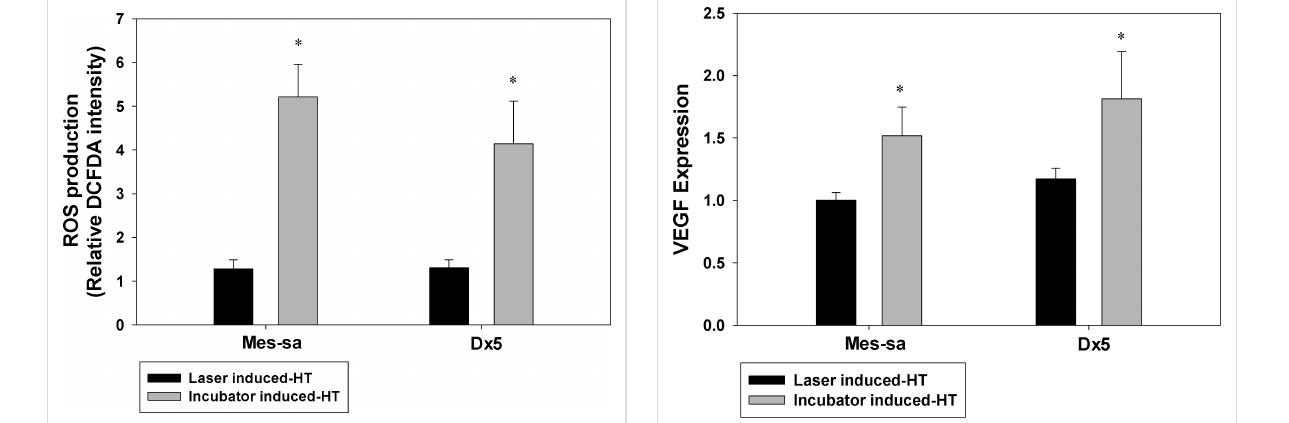
Figure 3: HT-induced ROS production following laser/NPs and incu- bator was measured in MES-SA and Dx5 cells. Fluorescent dye CM-H2DCFDA was used to measure the fluorescence intensity and normalized to values obtained from the control group (37 °C). * p < 0.05 indicates significant ROS production was observed in incubator induced-HT as compared to control. Laser/NP induced-HT did not result in enhanced ROS production as compared to control. Data presented as mean ± SD, n = 3.